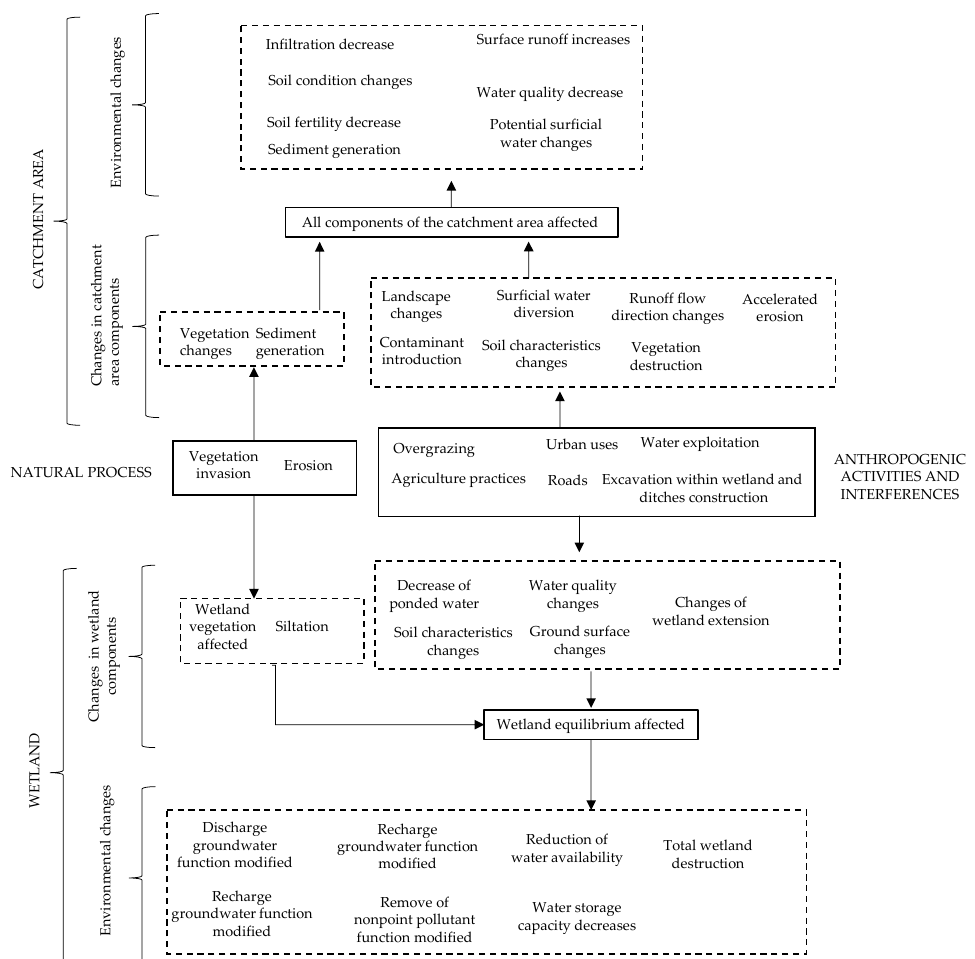
Figure 13. Main anthropogenic interferences, environmental changes, and affected functions of wetlands and catchment areas.